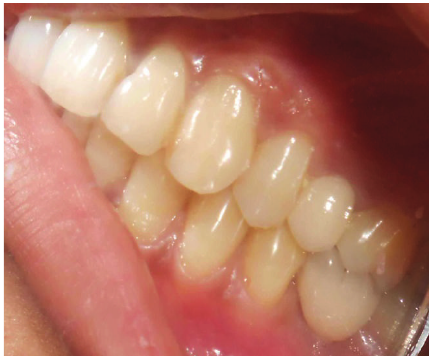
Figure 6: Extraportion cut with scissor.